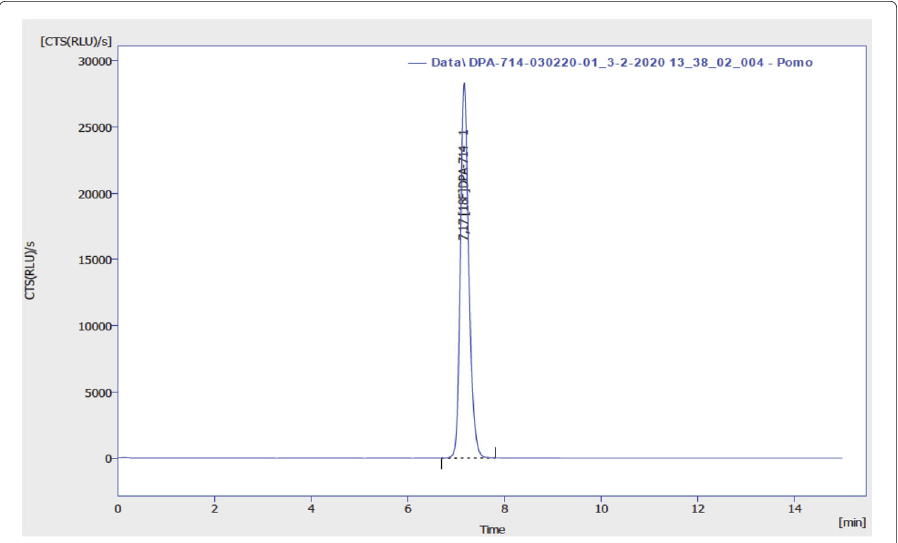
Fig. 6 Typical HPLC radiochromatogram obtained with [ 18 F]DPA-714 solution. RCP =